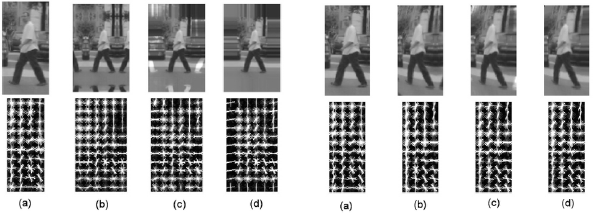
Figure 7. Visualization of HOG features from different border extension methods before ( left part) and after ( right part) the distortion process: ( a ) original image; ( b ) mirror extension; ( c ) mirror-inverted extension; ( d ) duplicate extension.